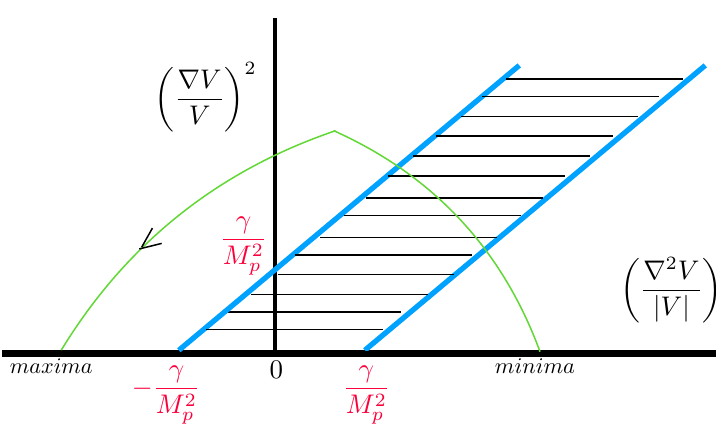
Figure 6 . Constraints for the potential of a single modulus when V ∝ m 2 γ . In the barred region the gravitational interaction is stronger than the scalar one. If a dS minimum exists, and the potential vanishes at infinity, there must be also a local maximum. This is not possible because going from a minimum to a maximum in field space (green line) one has to go through the forbidden region. The constraint disappears as M p → ∞